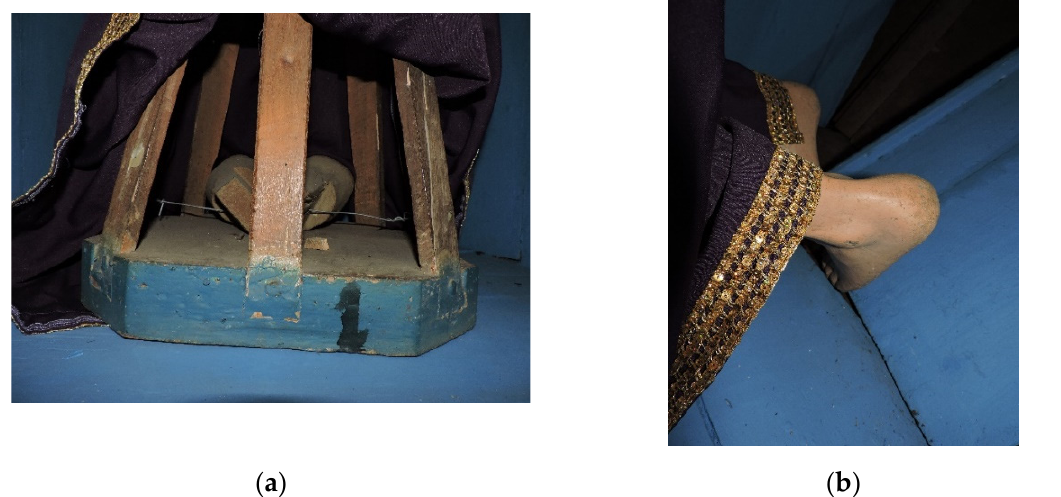
Figure 6. ( a ) Legs secured with wires. ( b ) Detail of the feet. Photos by Lia Brusadin, 1 January 2017.